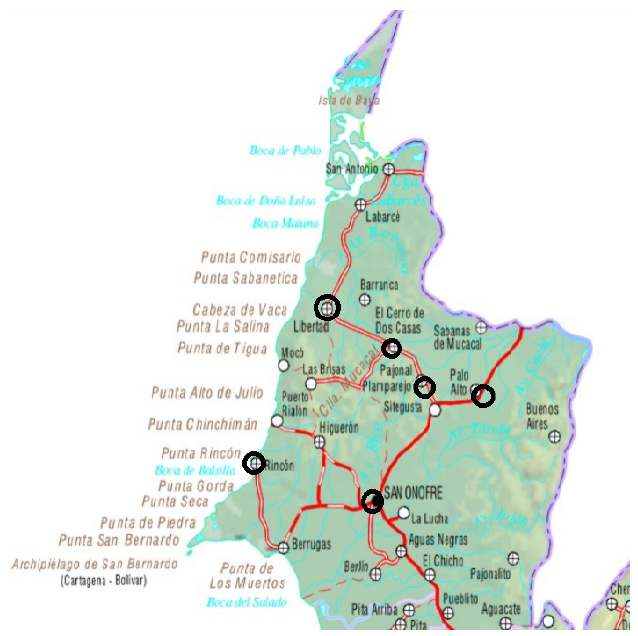
Figure 1. Municipality of San Onofre and nearby towns inhabited by Afro-descendant communities who are victims of armed violence. In the circles are highlighted: Libertad, Rincón del Mar, Pajonal Plan Parejo, San Onofre others. The figure was taken from the Agustín Codazzi Geographical Insti- tute of Colombina.